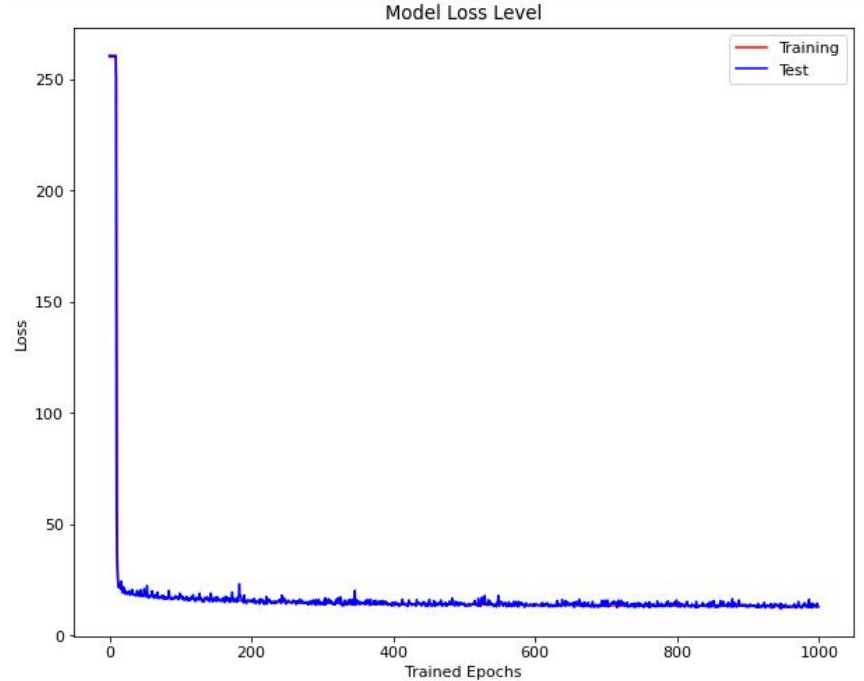
Figure 2. Training summary for the model loss level.